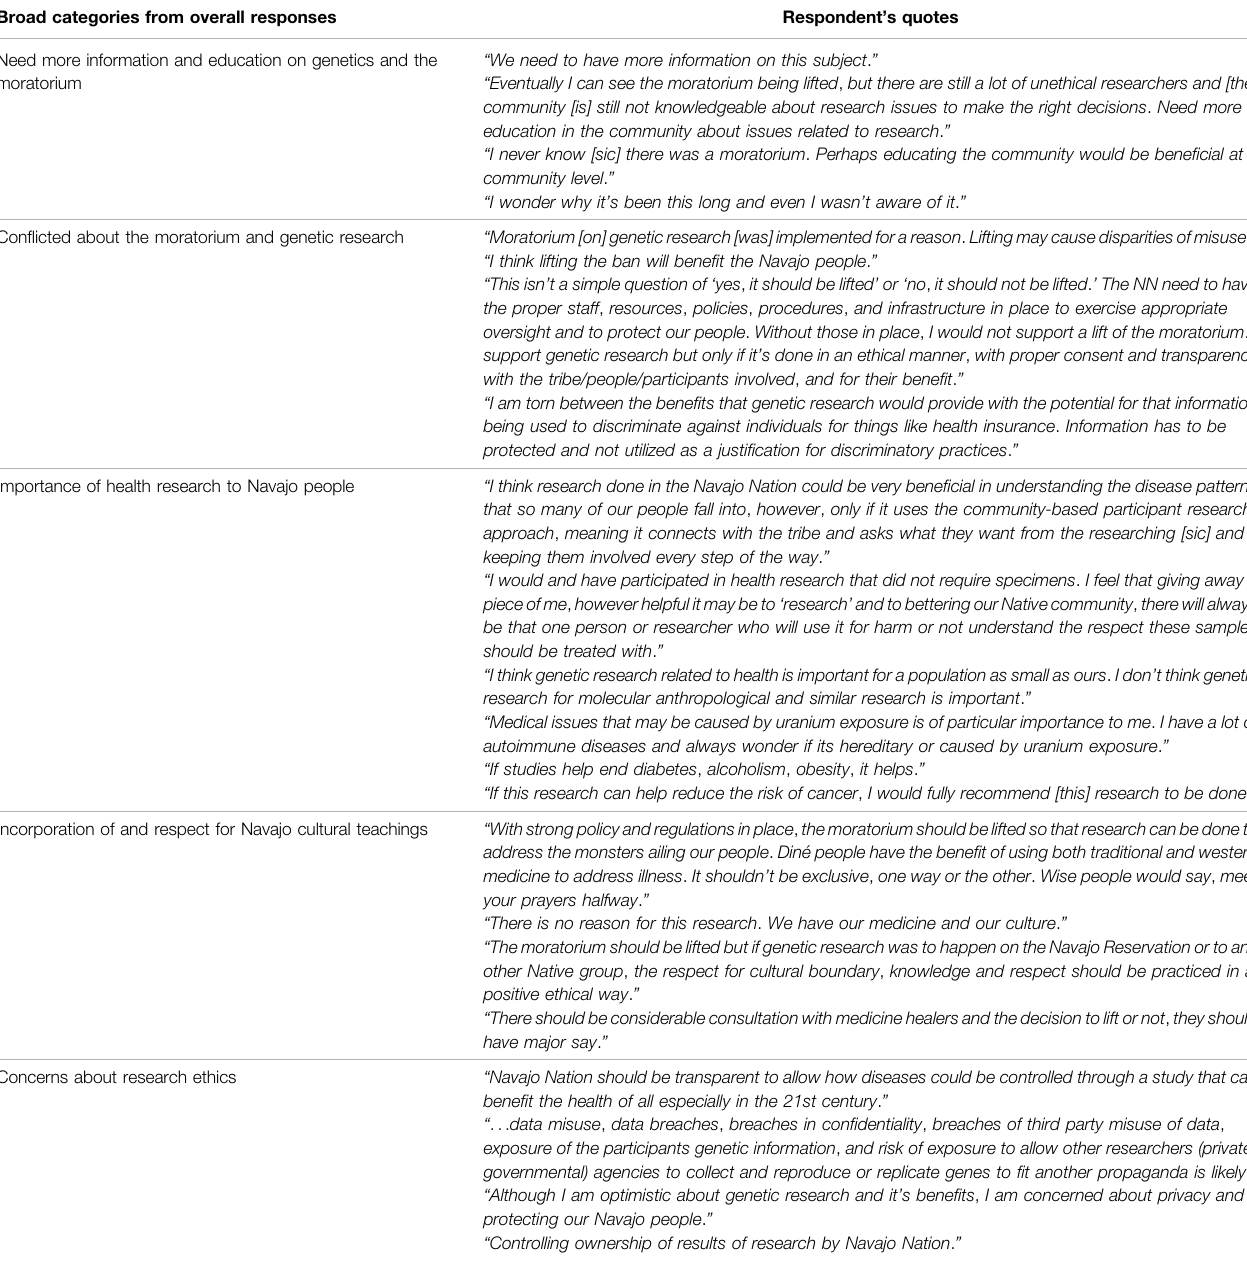
TABLE 3 | Themes and respondent ’ s quotes about the moratorium and genetic